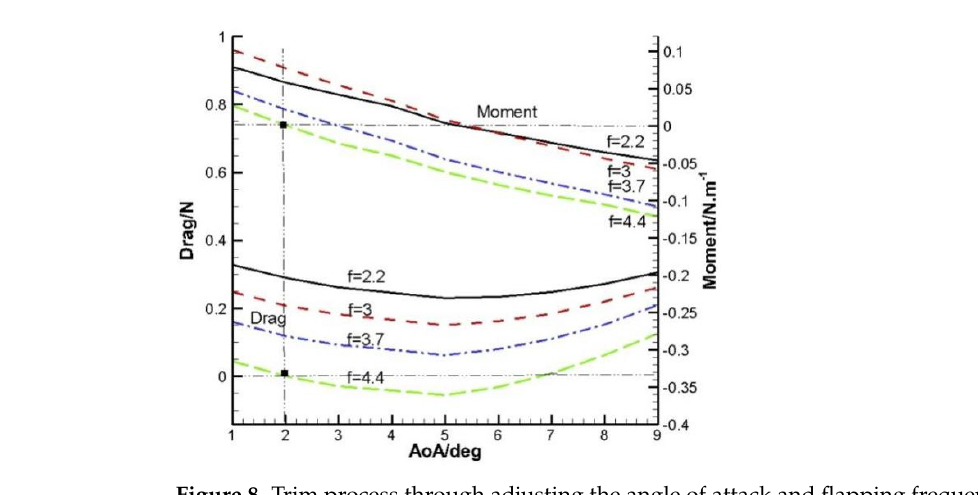
Table 4. The trimmed results by two methods independently.